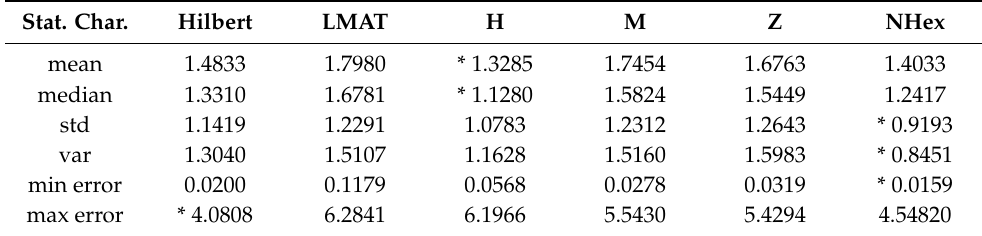
Table 4. Statistical characterization of all mobile path planning models in terms of std of errors for WCL.